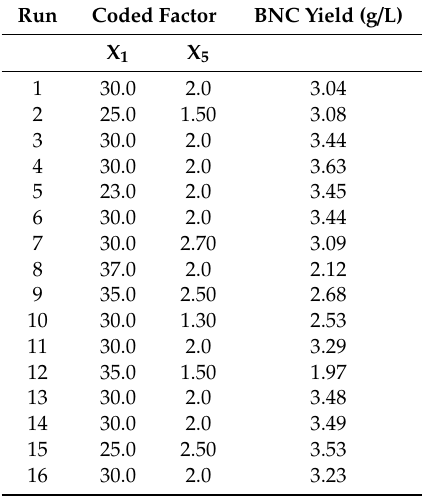
Table 3. Factor levels evaluated in the optimization stage and results of the BNC yield.